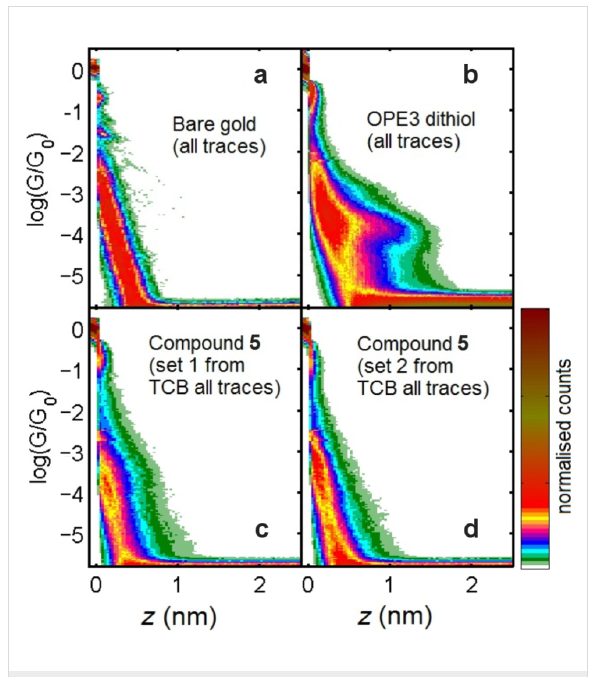
Figure 3: 2D histograms resulting from break junction experiments on an unmodified gold sample (a), OPE3-dithiol drop-cast from TCB (26% of traces displayed plateaus around 10 − 4 G 0 ) (b), compound 5 drop- cast from TCB (c) and, compound 5 dip-cast from dichloromethane (d). All measurements were performed in dry ambient